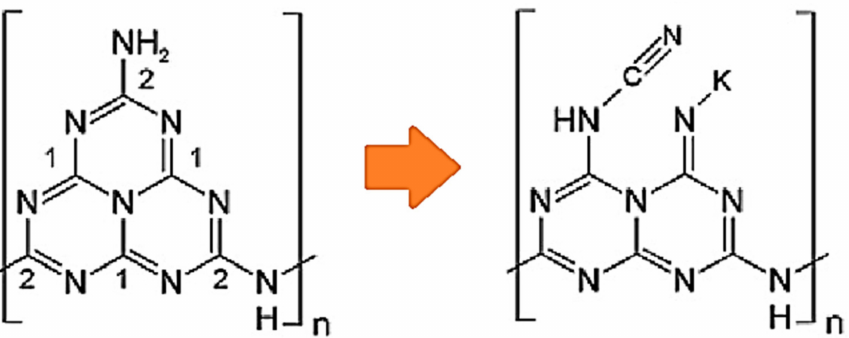
Figure 7. The proposed melon structure changes due to K doping. Reproduced with permission from Ref. [51].